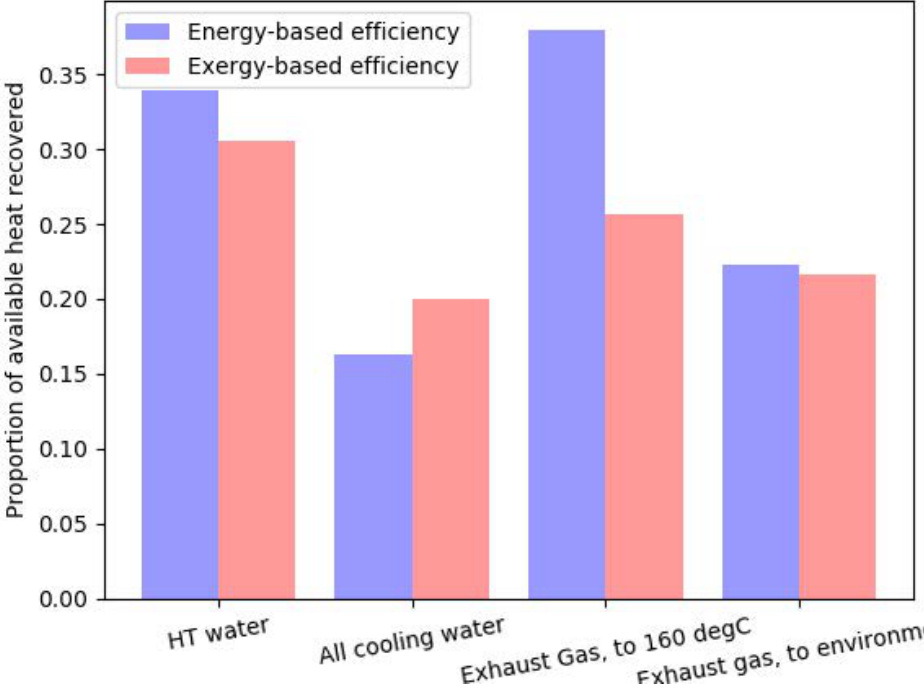
Figure 19. Energy and exergy efficiency of the WHR